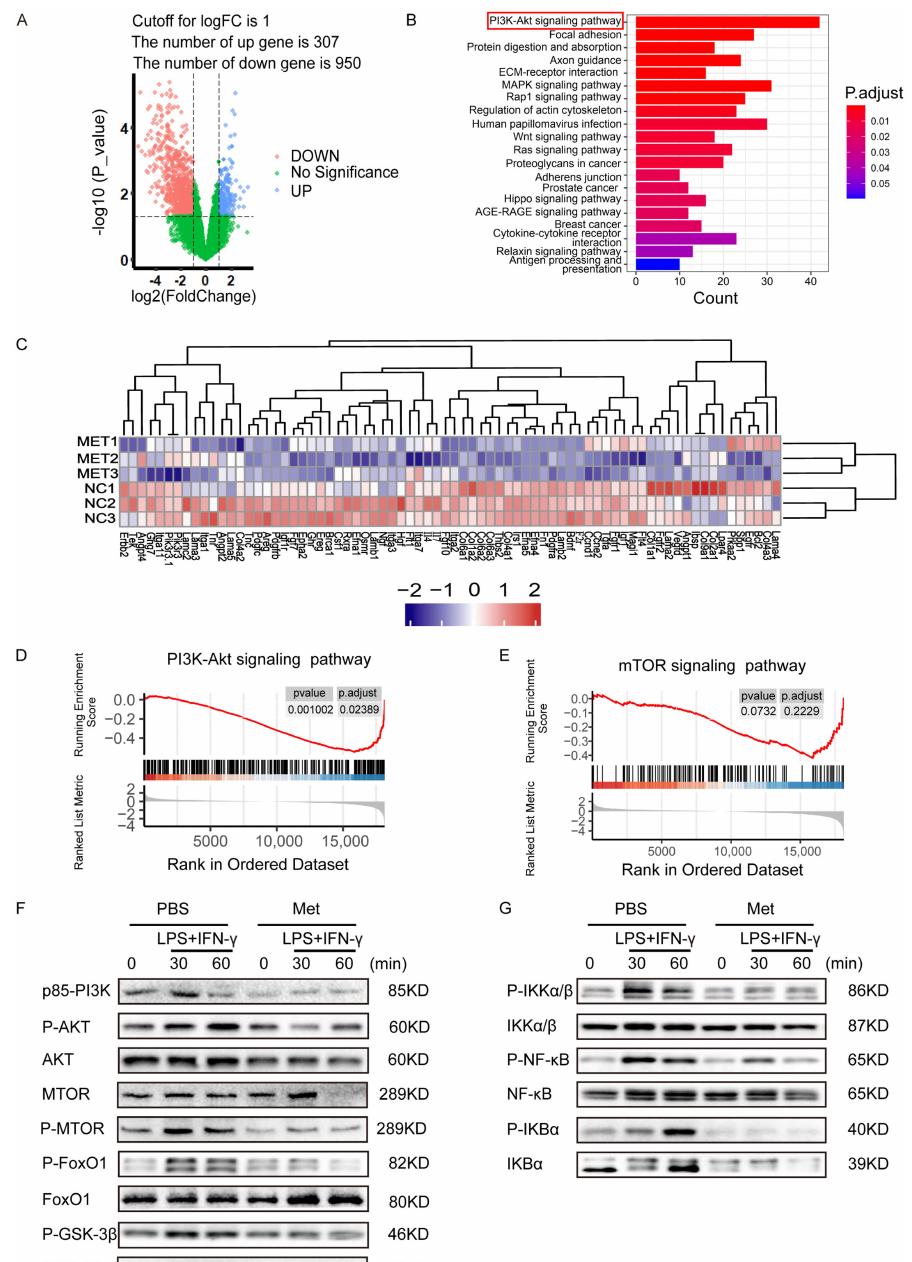
Figure 4. Potential regulatory role of metformin in PI3K/AKT signaling in M1 macrophages. ( A ) Vol- canic Map of DEGs of metformin-treated M1 macrophages or M1 macrophages. Blue and red colors represent high and low expression values, respectively. ( B ) Representative varied KEGG pathway categories affected by metformin in M1 macrophages. The most significant enriched pathway was circled. ( C ) Heat map of DEGs of downstream genes of PI3K/AKT pathway of metformin-treated M1 macrophages or M1 macrophages. ( D , E ) Gene set enrichment analysis (GSEA) was used to identify the distribution of genes in the PI3K/AKT and mTOR pathway gene set of metformin-treated and control M1 macrophages groups. ( F , G ) Immunoblot images showing the effect of metformin on the expression of p-AKT/AKT, p-mTOR/mTOR, p-FoxO1/FoxO1, p-GSK3 β /GSK3 β , and signal molecules in NF- κ B